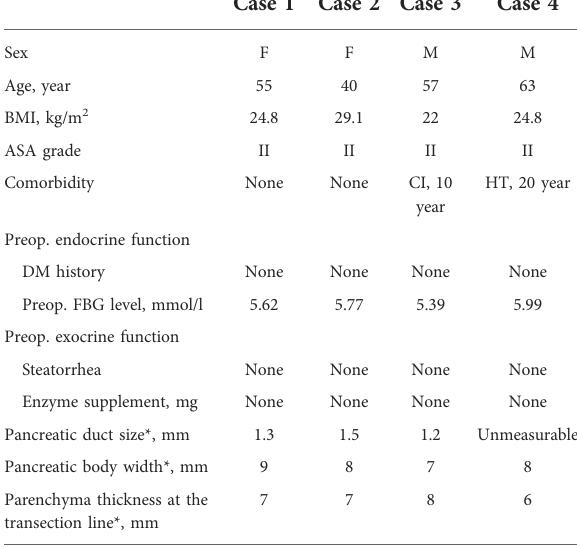
TABLE 1 Baseline patient